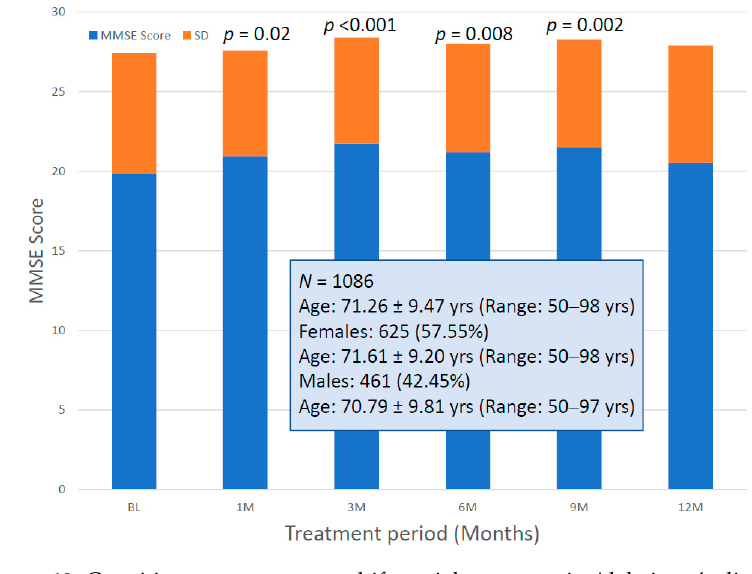
Figure 13. Cognitive response to a multifactorial treatment in Alzheimer’s disease.